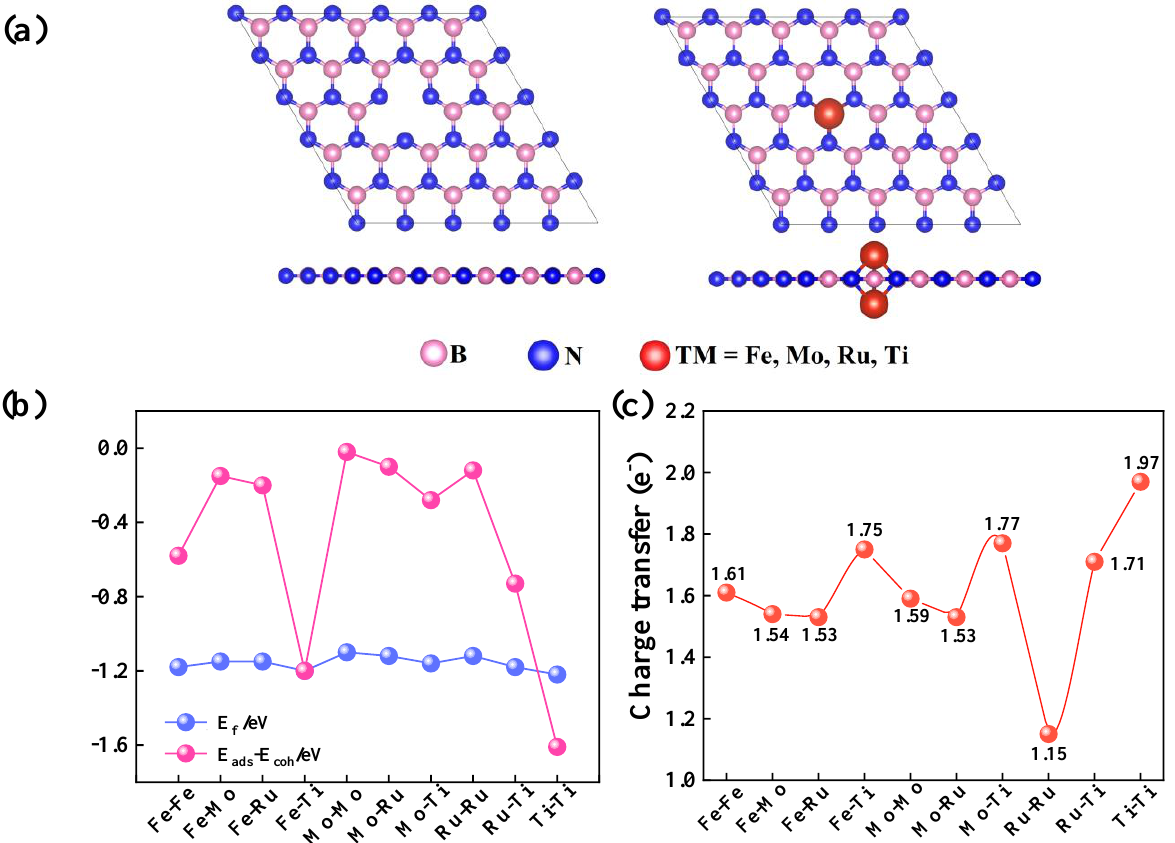
Figure 1. ( a ) Schematic configurations of TM 1 -TM 2 @V B -BN. ( b ) Calculated formation energy and the difference between the adsorption energy and cohesive energy of the TM 1 -TM 2 @V B -BN systems. ( c ) Charge transfer from the TM pair to the V B -BN substrate.